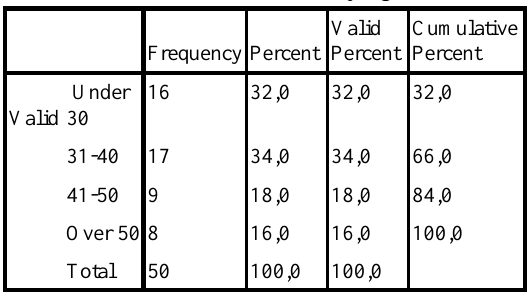
Table 2. Distribution by Age